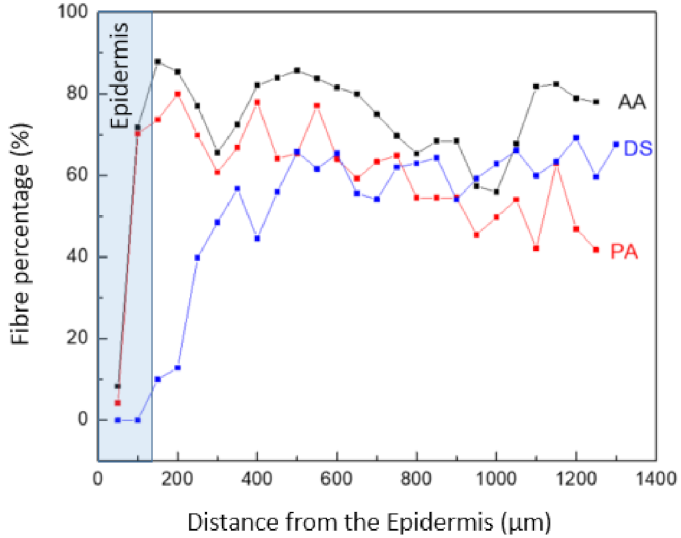
Figure 11. Fiber percentage in the transversal section of the culm of AA, PA, and DS bamboo species. The external